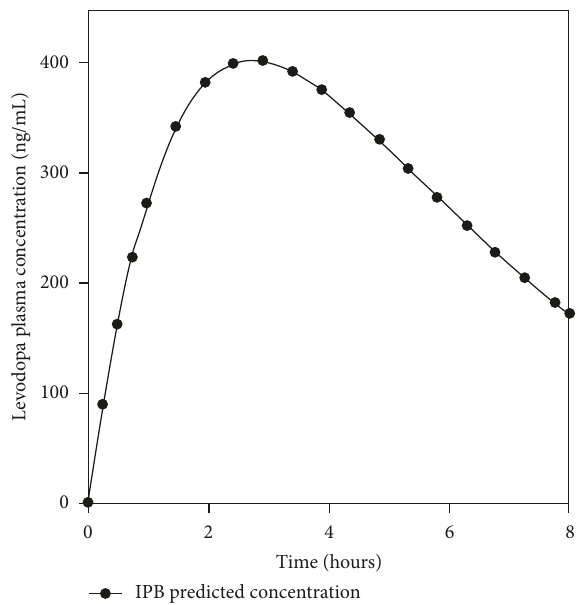
Figure 9: Predicted L-dopa plasma concentrations from 0.24 to 8